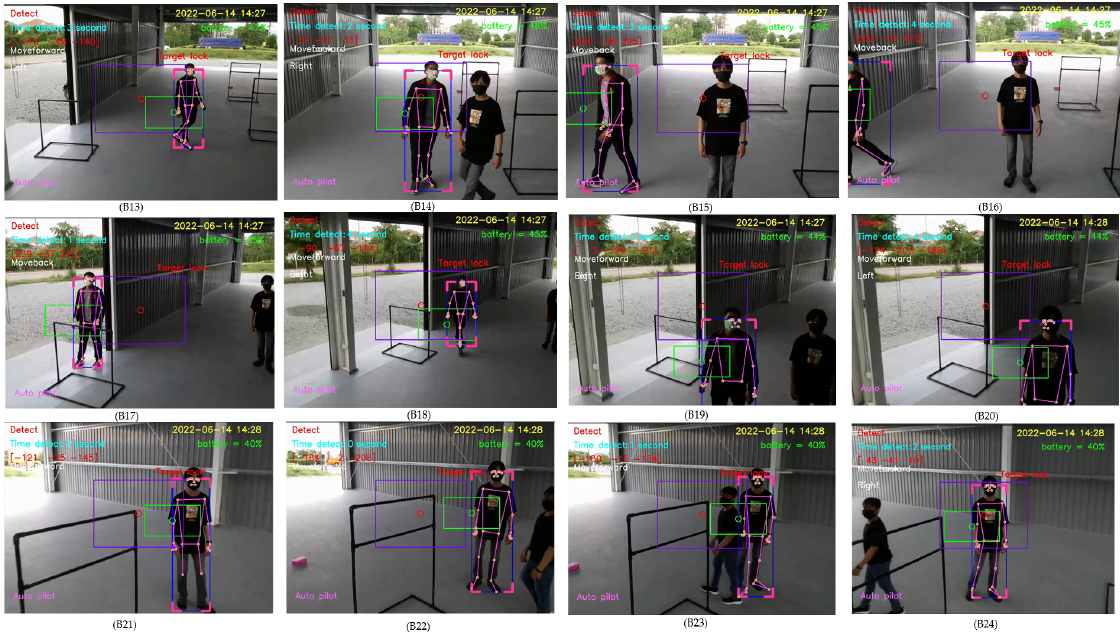
Figure 39. Human detection where a new person moves at the same distance as the first